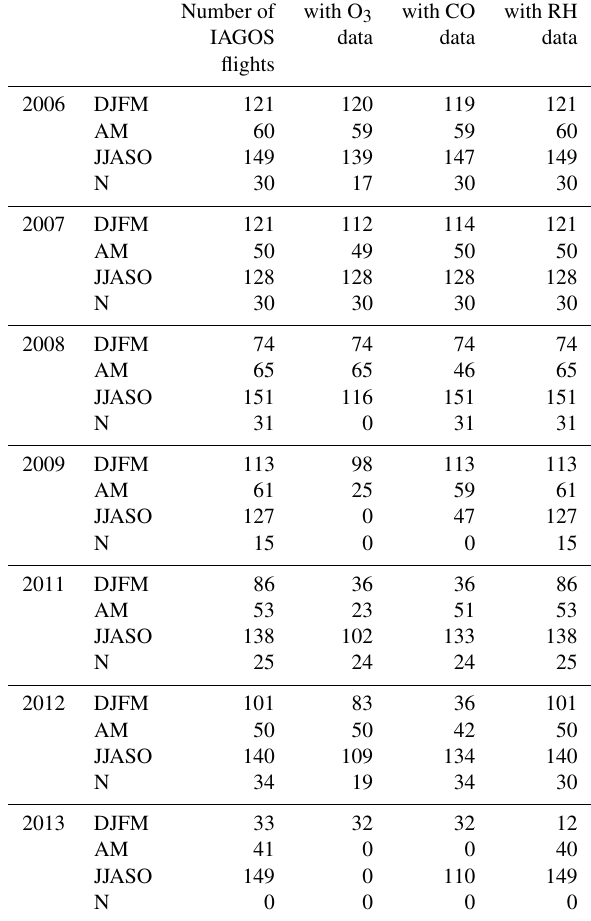
Table 1. List of available IAGOS data per season (see Sect. 2.4 for more details on season